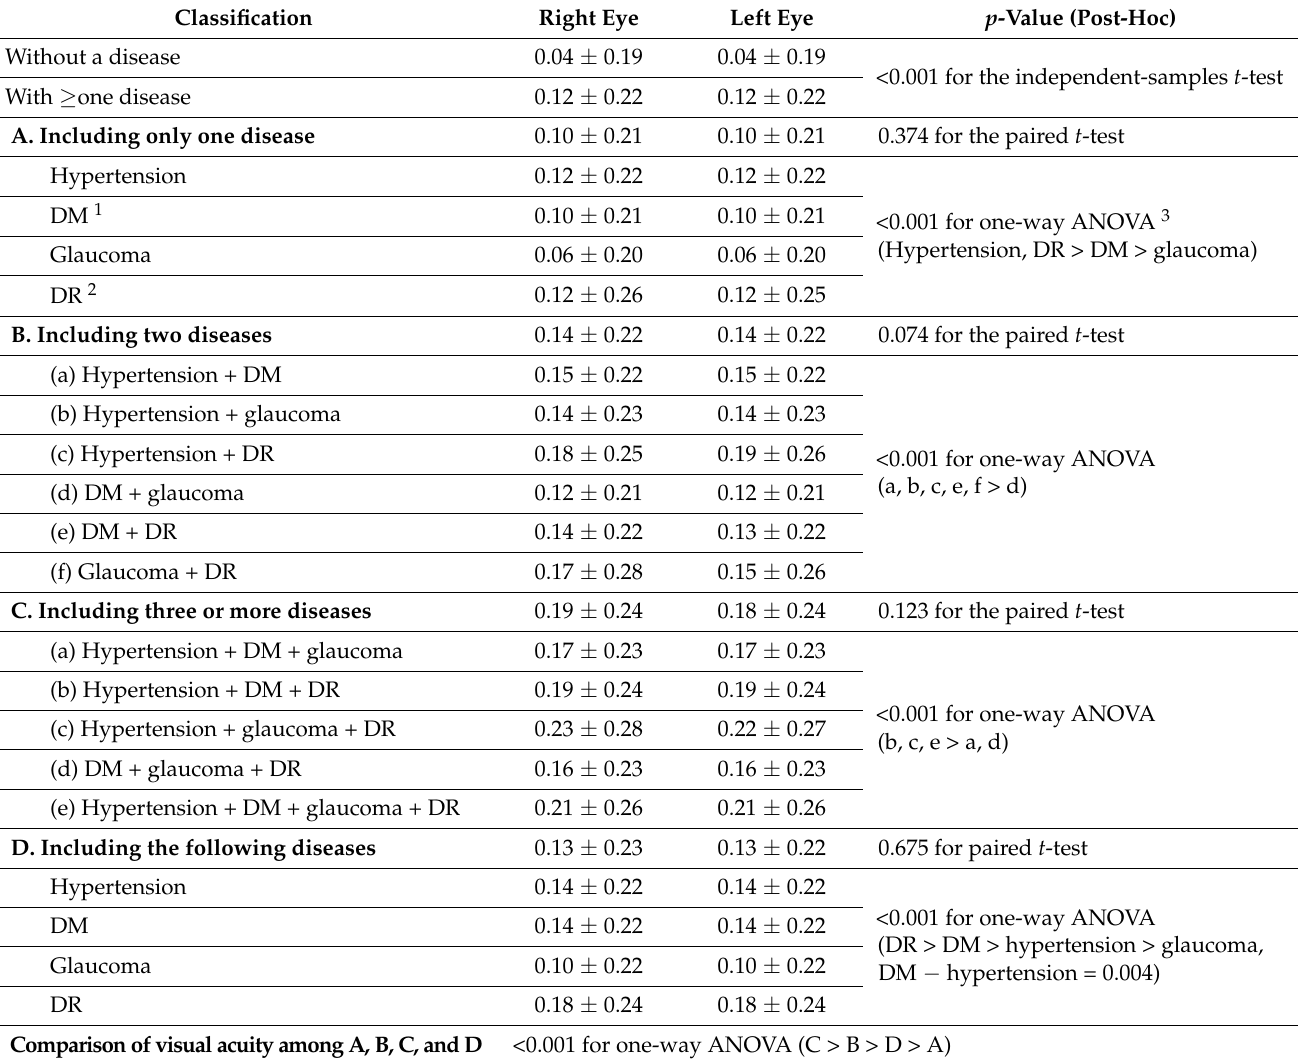
Table 2. Mean and standard deviation visual acuity according to diseases associated with reduced visual